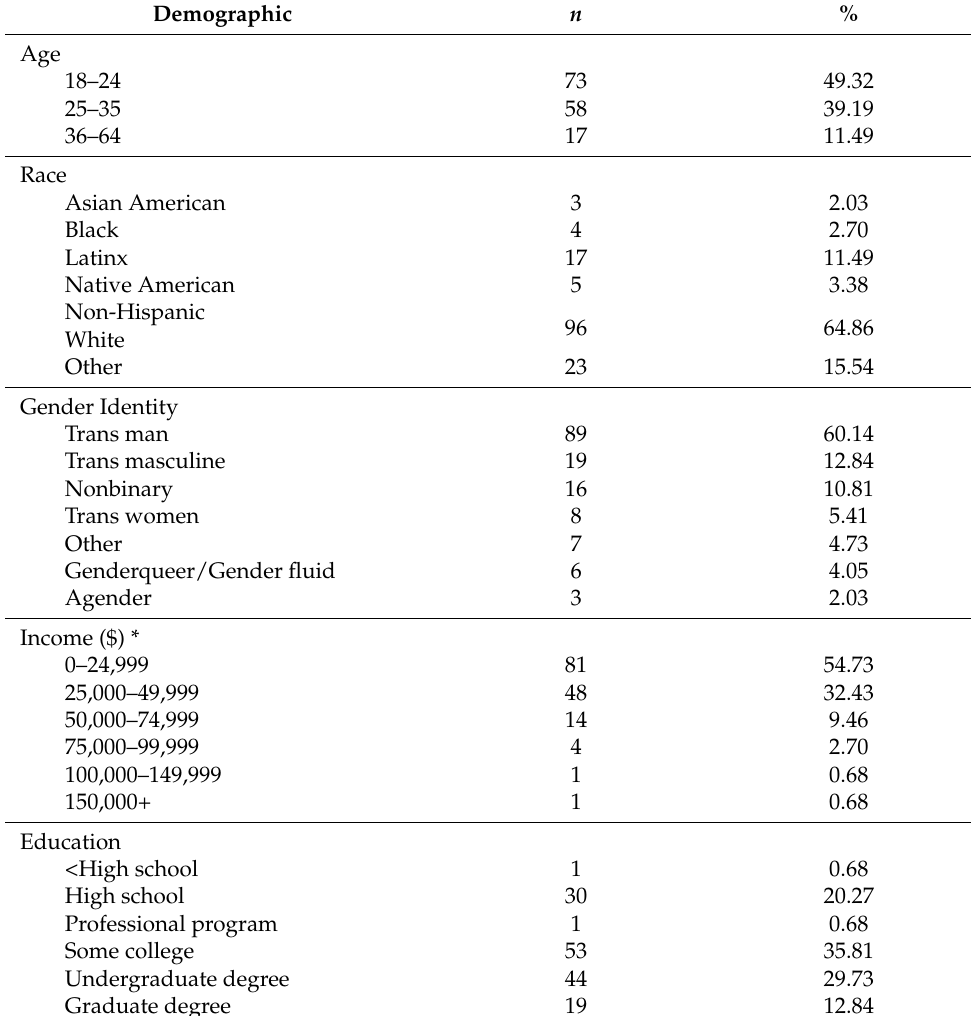
Table 1. Sociodemographic Characteristics of Participants ( n =